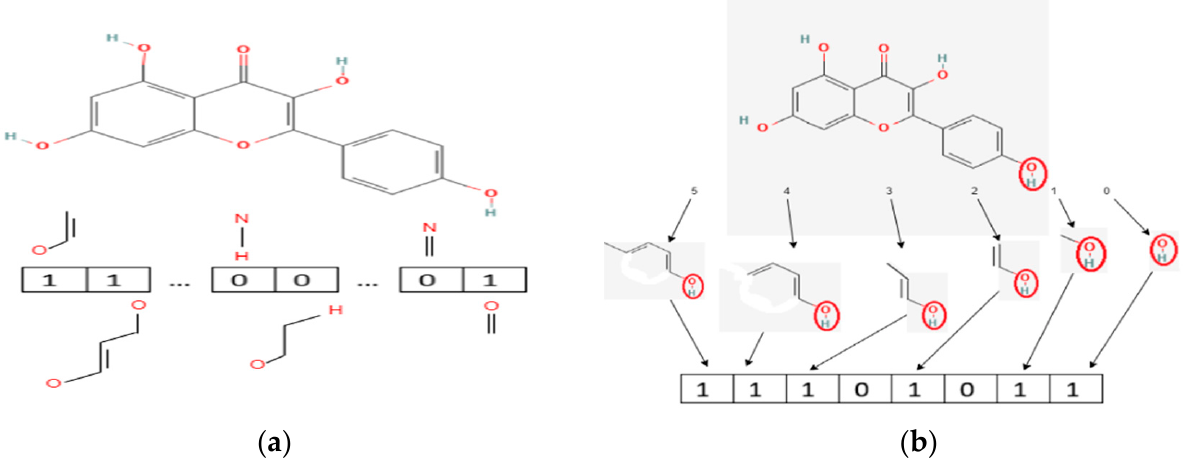
Figure 1. ( a ) Illustration of the substructure-based fingerprint to represent the chemical structure of a compound. Bit 1 indicates that the substructures they represent are present in the molecule. In contrast, bit 0 indicates the substructure is not present in the molecule ( b ) Illustration of the topological-based fingerprint to represent the chemical structure of a compound. In this case, a linear path-based (daylight) fingerprint with a path length of 5. Every fragment found from the starting point (circled) to a certain path length is hashed to the corresponding bit in the fingerprint. Circular fingerprints follow a similar approach, but instead of using path length, it used the radius of the starting point to find the molecule